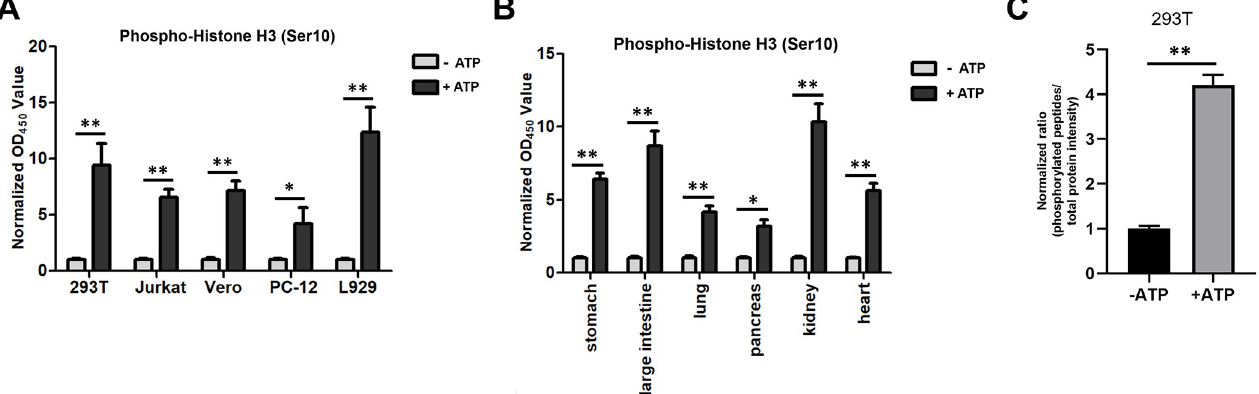
Fig 4. Application of our in vitro phosphorylation system for ELISA and LC-MS/MS. (A) 293T, Jurkat, Vero, PC-12, and L929 cells were cultured, harvested, and lysed in in vitro buffer. Cell lysates were then incubated in the phosphorylation system with or without 5 mM ATP. After centrifugation, the supernatants were used for ELISA with anti-phospho-histone H3 (Ser10) antibodies. (B) Stomach, large intestine, lung, pancreas, kidney, and heart tissues from mice were ground and lysed, and supernatants were incubated in in vitro buffer with or without 5 mM ATP. The supernatants were then applied for ELISA with anti-phospho-histone H3 (Ser10) antibodies. (C) Each cell sample contained about 1 × 107 293T cells, then cells were lysed and incubated with or without ATP for 30min at 30˚C. After that, proteins in lysates were conducted with digestion, phosphorylated peptides enrichment and LC-MS/MS to calculate the ratio of phosphopeptides to total protein